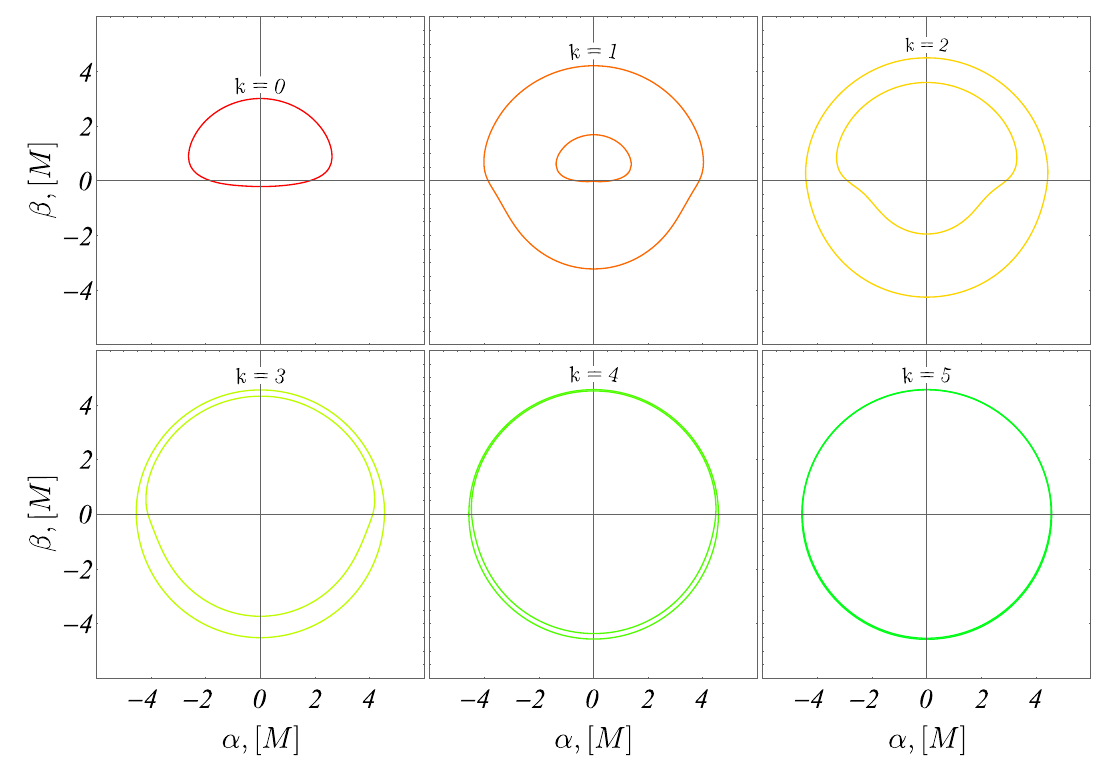
Fig. 8 Images of the circular orbit located at r = 1 . 227 M as seen by an observer at { r obs = 5000 M , i = 80 ◦ } . We illustrate the primary image of order k = 0 and the secondary images up to the order k =